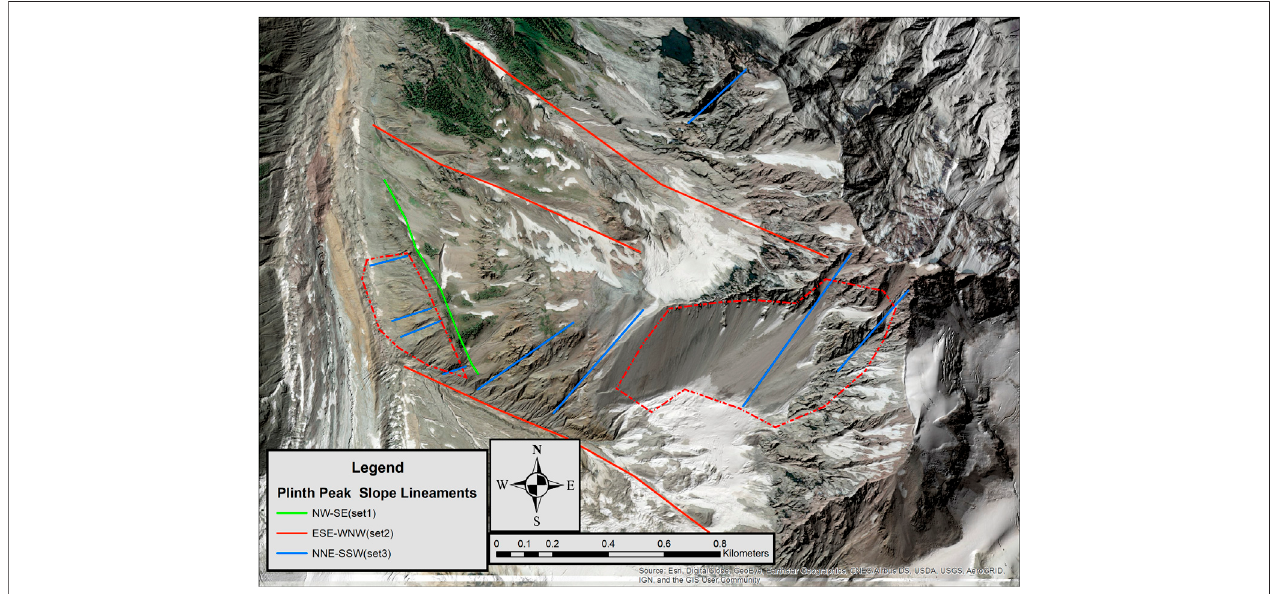
FIGURE13 | Highresolution ESRI satellite image overlayed on top ofthe lidar-based hillshade map; shown are three sets of lineaments thatmost likely structurally control the Plinth Peak slope deformation. The dashed red polygon represents areas of frequent rockfall.